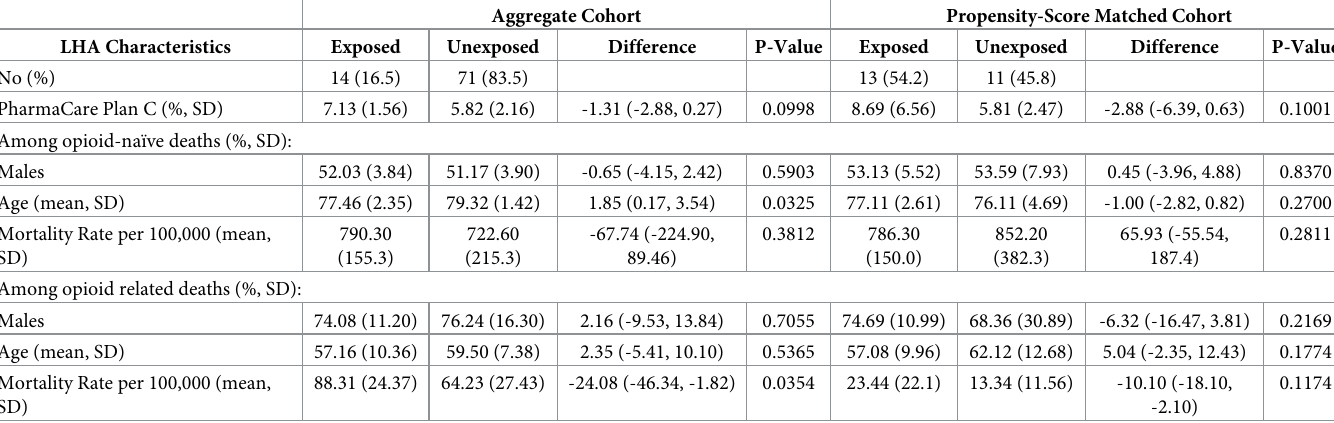
Table 2. Characteristics of exposed and control LHAs in aggregate and restricted to propensity-score matched cohorts,